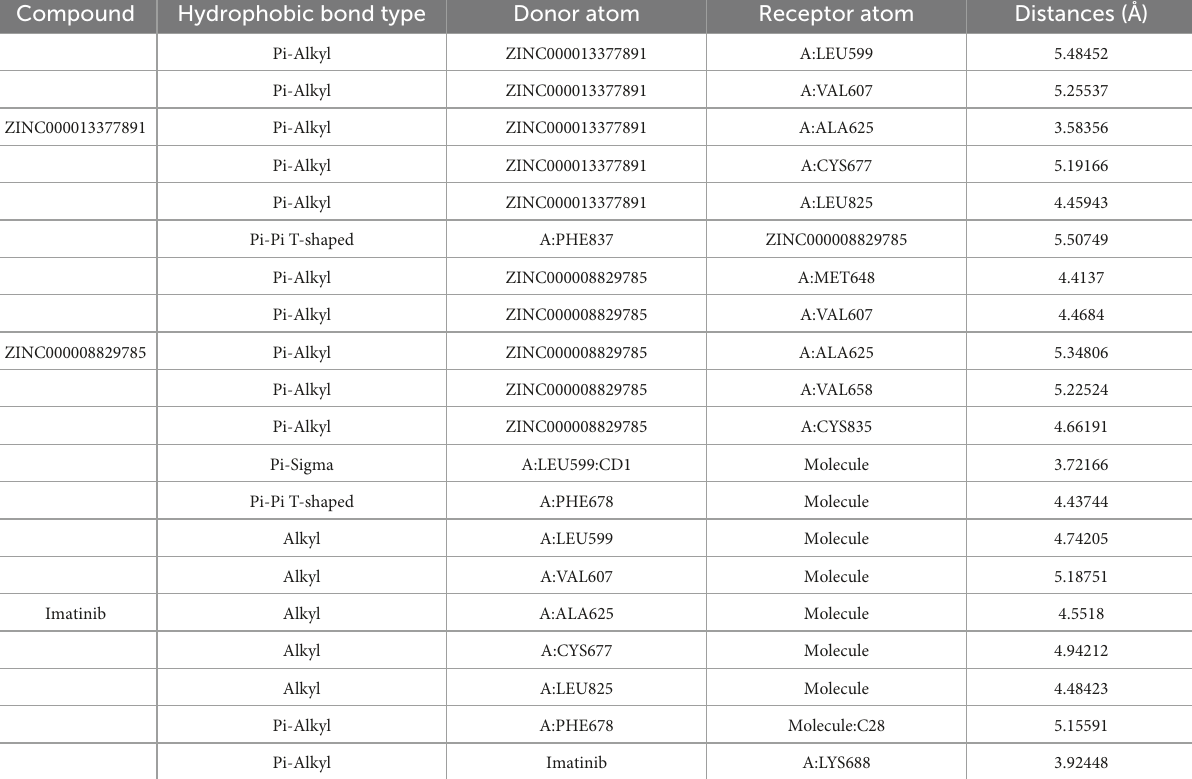
TABLE 6 Hydrophobic interaction parameters for each compound with platelet-derived growth factor receptor α (PDGFRA).